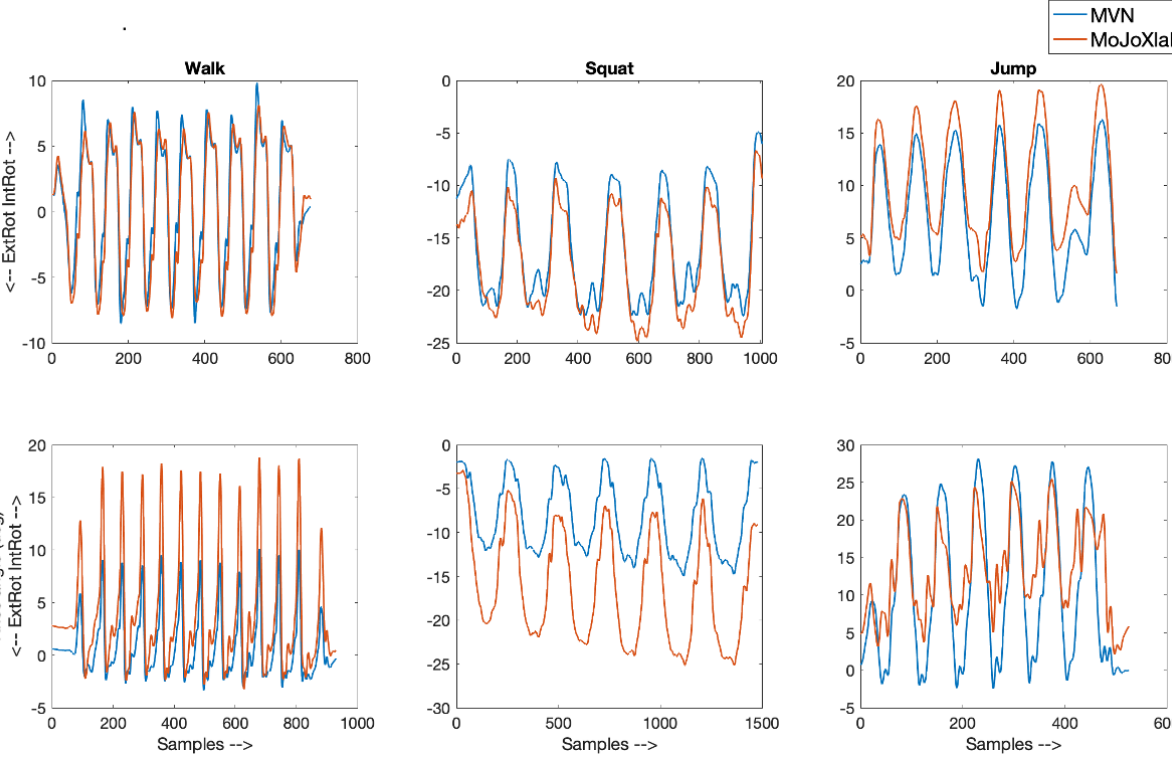
Figure 7. Representative transverse plane joint angle waveforms selected from anterior cruciate ligament reconstruction participant data set. Waveforms for the hip (top row) and knee (bottom row) joint angles obtained from MVN Analyze (blue) and our custom software MoJoXlab (orange) for walking (left), squat (center), and jump (right) tasks. The y-axis represents joint angles in degrees, and the x-axis represents data samples across the entire